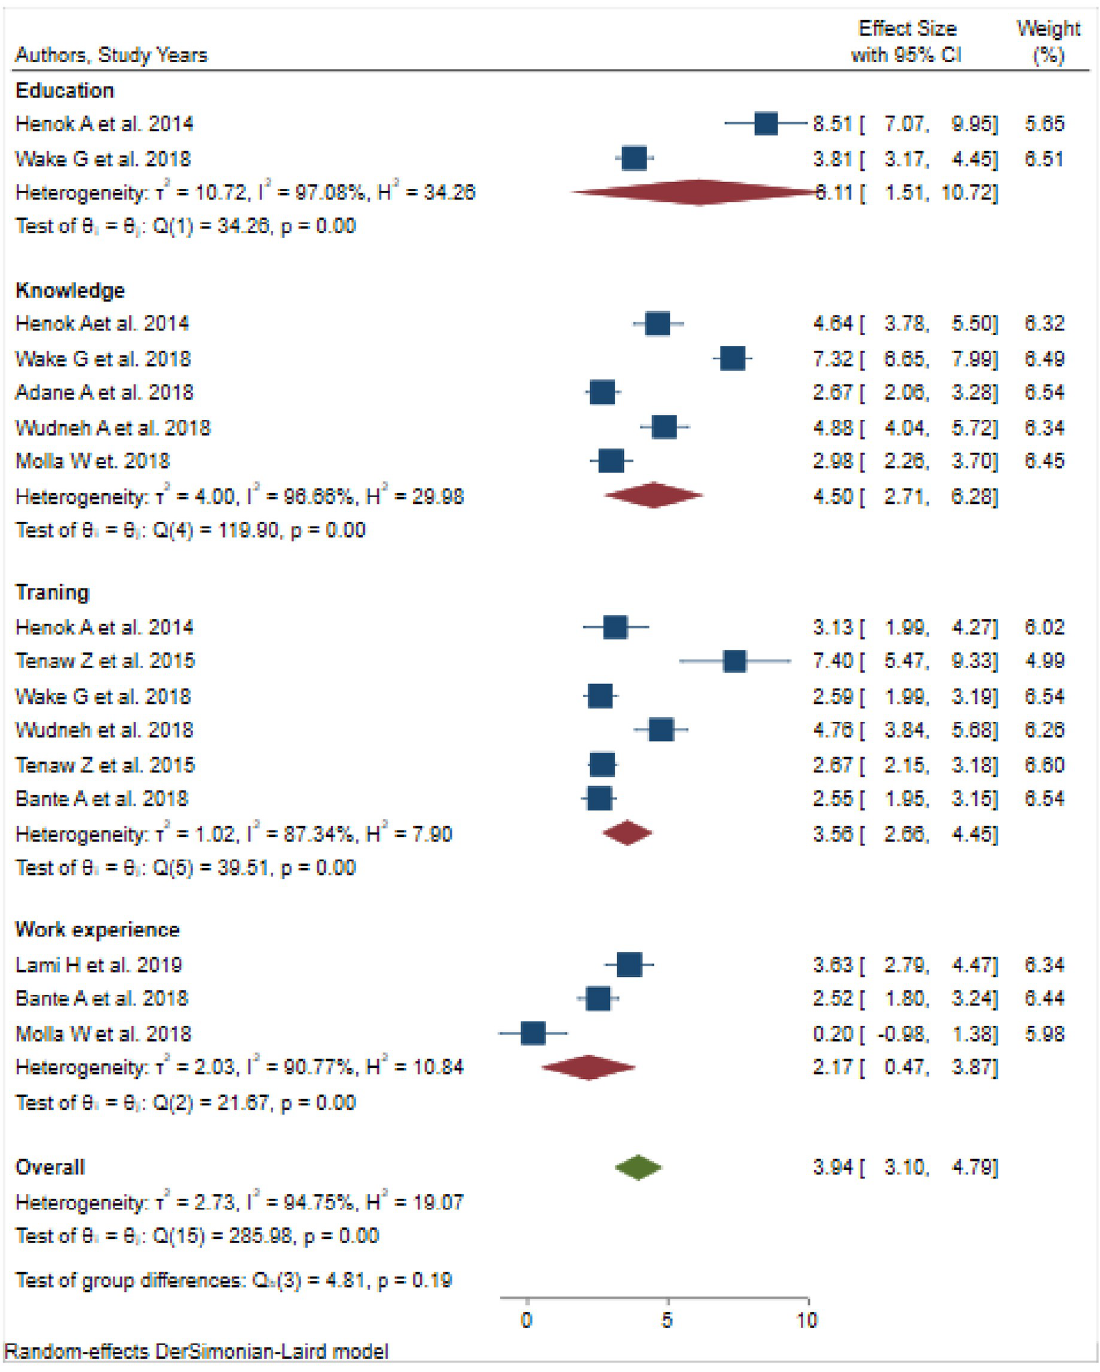
Fig 5. Forest plot of the association between training, educational status, knowledge of active management practices of the third stage of labour, and work experience with the practice of active management of the third stage of labour in Ethiopia.